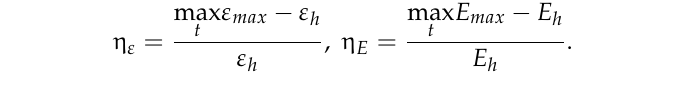
h ( a ) and E h ( b ), M = 8,